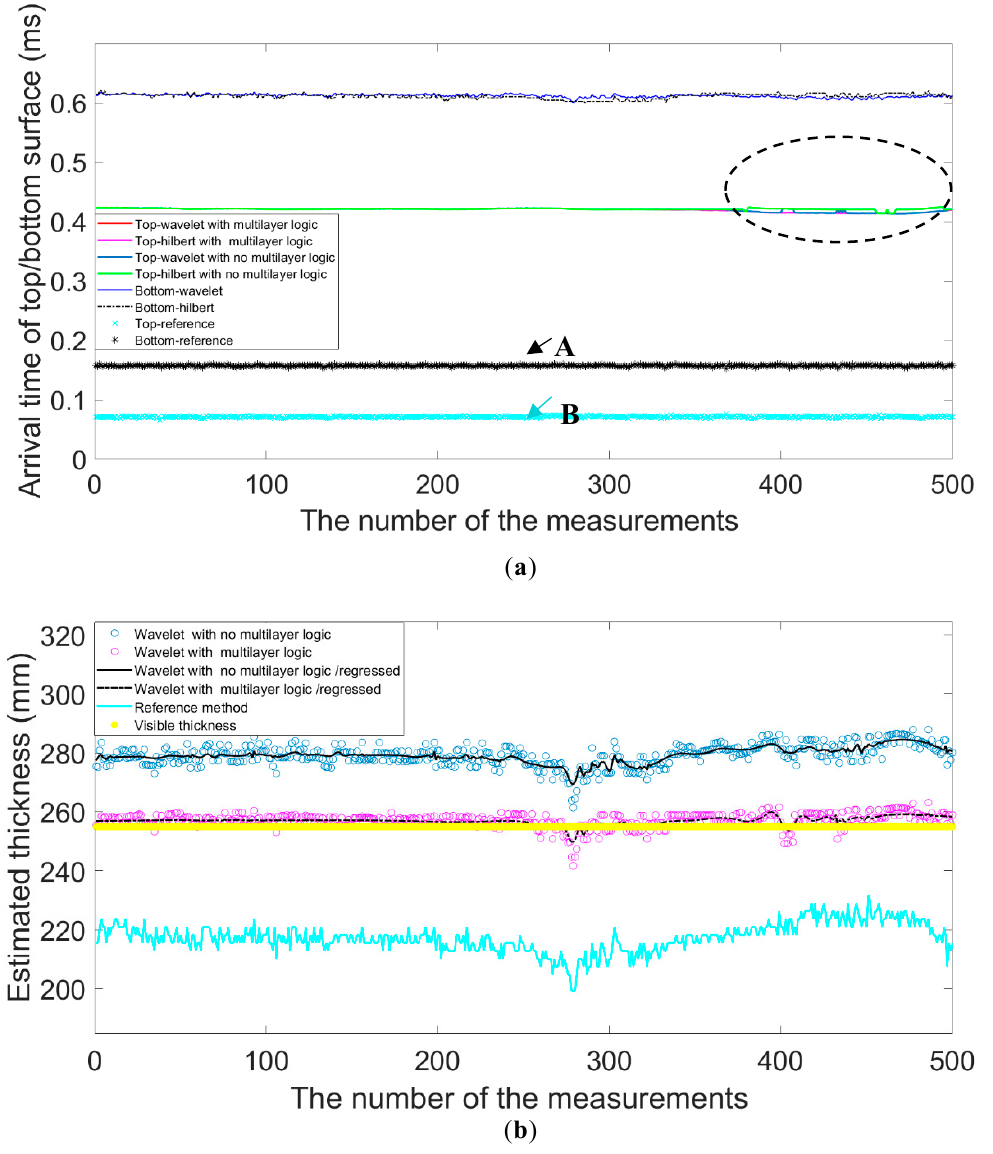
Figure 10. The results: ( a ) The arrival time of the top and bottom surface; ( b ) The estimated thickness by di ff erent methods. Table 5. Comparison of the thickness with di ff erent methods